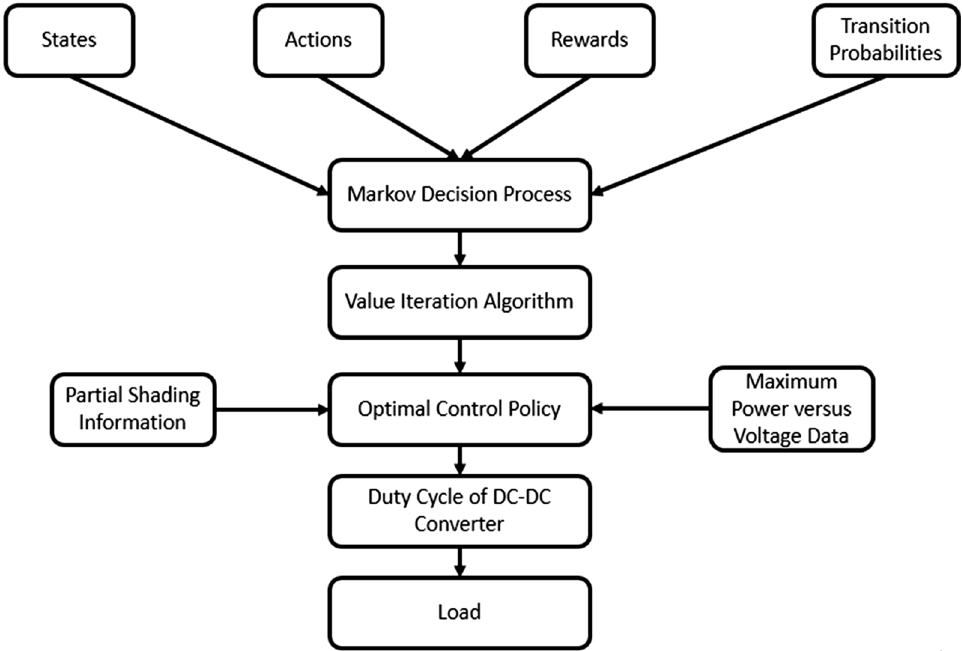
Fig. 3 Flowchart of the proposed